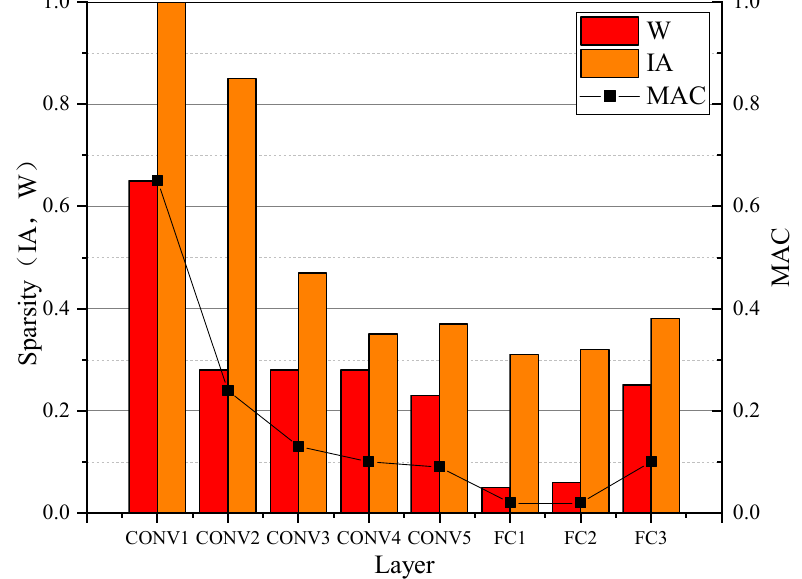
Figure 5. The sparsities of Weight (W) and input activation (IA) and reduction of multiplication and accumulation (MAC).